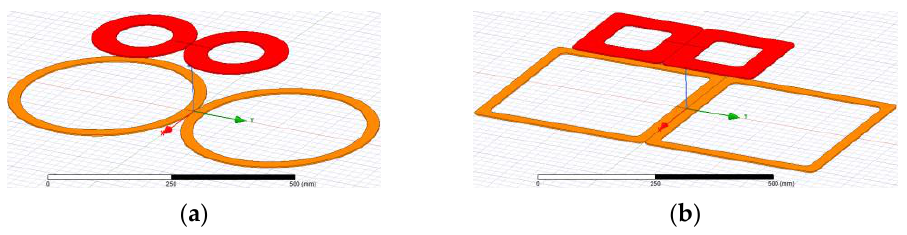
Figure 3. The characteristic of DD couplers versus offset: ( a ) circular DD coils; ( b ) rectangular DD coils.